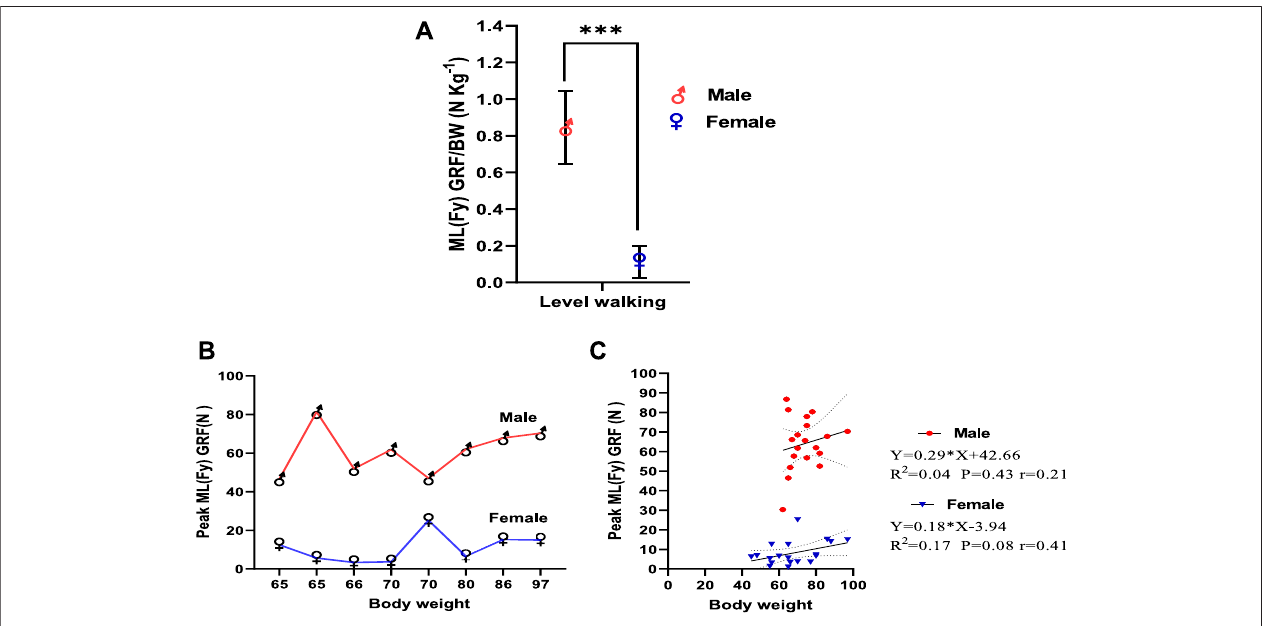
FIGURE4|(A) Mediolateralforcevalue(Fy)inmaleandfemaleparticipants. (B) Inter-subjectvariationinmediolateralforcevalue(Fy)inmaleandfemaleparticipants by weight. (C) Linear regression of body weight versus peak ML GRF in midstance and terminal stance phases of level